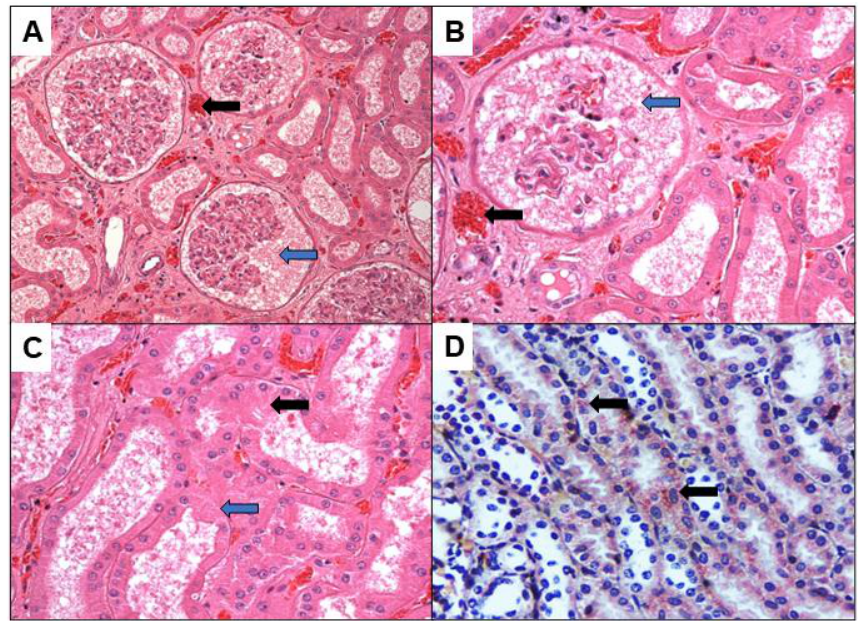
Figure 1. ( A – D ) Histopathology of sections stained by HE ( A – C ) and IHC method for YFV ( D ) in the kidney of fatal cases of YF. The figure demonstrates renal parenchymal congestion (black arrows in A , B ), necrosis of glomerulus and tubular epithelium (blue arrows in A – C ). YFV antigen demonstrated in the epithelium of renal tubular structures (black arrows in D ). Magnification 200 × ( A , D ) and 400 × ( B , C ). Quantitative analysis of the phenotypic markers of M1/M2 macrophages in the renal parenchyma between the samples of fatal cases of human YFV and control was performed using markers with monoclonal antibodies against CD163, CD68, inducible nitric